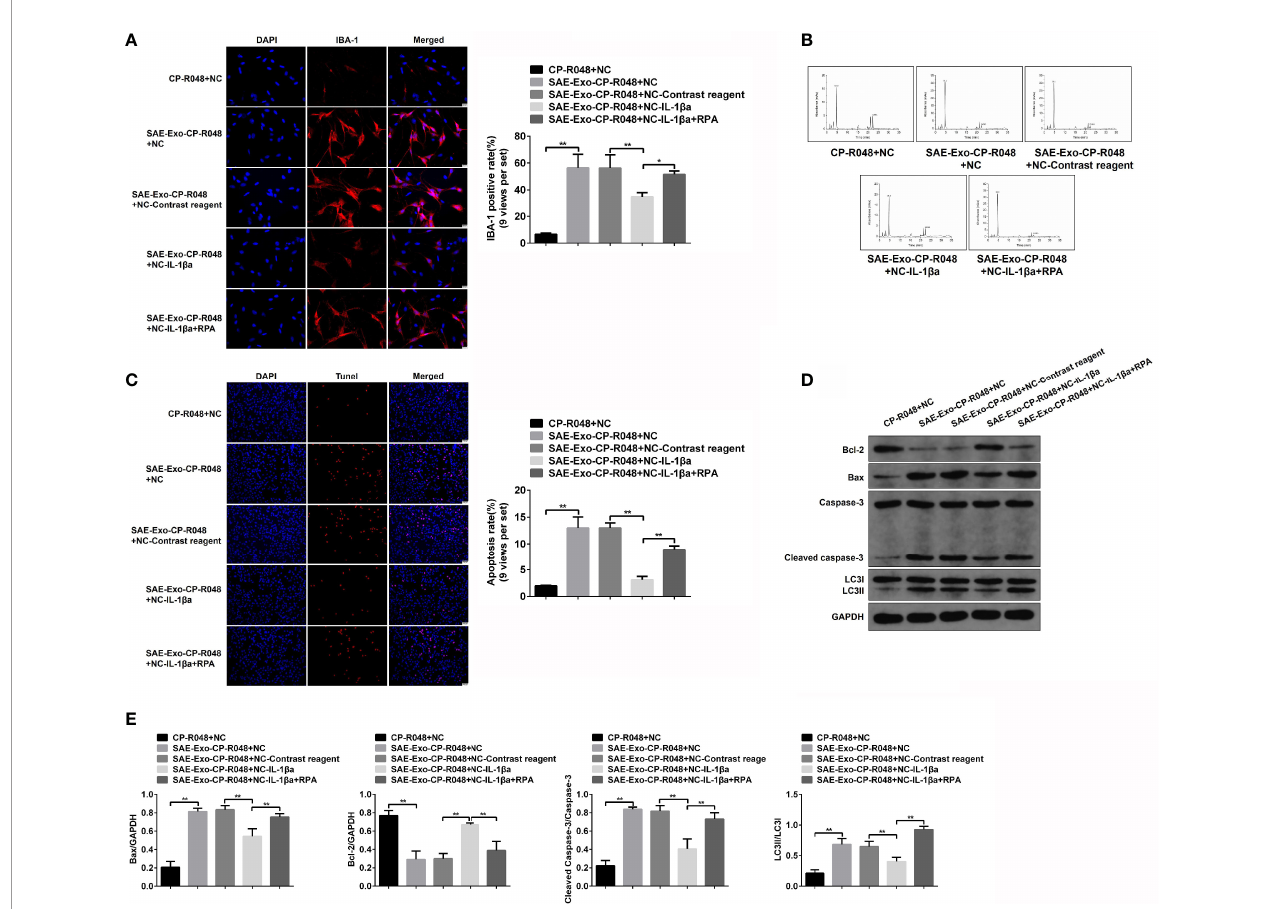
FIGURE 8 | Effects of autophagy in IL-1 b -induced neuron injury. (A) Firstly, CO-R048 cells were treated with intestinal epithelial cell exosome from Sham and SAE rats. The supernatants were collected for the incubation of H19-7 cells. H19-7 cells were also exposed to control reagent, IL-1 b antagonist, and autophagy activator rapamycin. Thus, there were fi ve groups of cells: H19-7 cells treated with control supernatant, H19-7 cells treated with disease supernatant, control reagent-exposed H19-7 cells treated with control supernatant, IL-1 b antagonist-exposed H19-7 cells treated with control supernatant and IL-1 b antagonist, and IL-1 b antagonist and rapamycin-exposed H19-7 cells treated with disease supernatant. Relative quantitation of IBA-1-positive cells as shown in the right (nine views per set). (B) In the above cells, the concentrations of Glu and GABA were detected by HPLC. (C) Apoptotic cells were determined by TUNEL assay in these cells. Relative quantitation of TUNEL-positive cells as shown in the right (nine views per set). (D) The protein levels of Bcl-1, BAX, cleaved caspase 3, and LC3II/I were detected by WB in the cells. (E) Protein quantitative analysis of Bcl-1, BAX, cleaved caspase 3, and LC3II/I in panel (D) of this fi gure. *P < 0.05. **P <